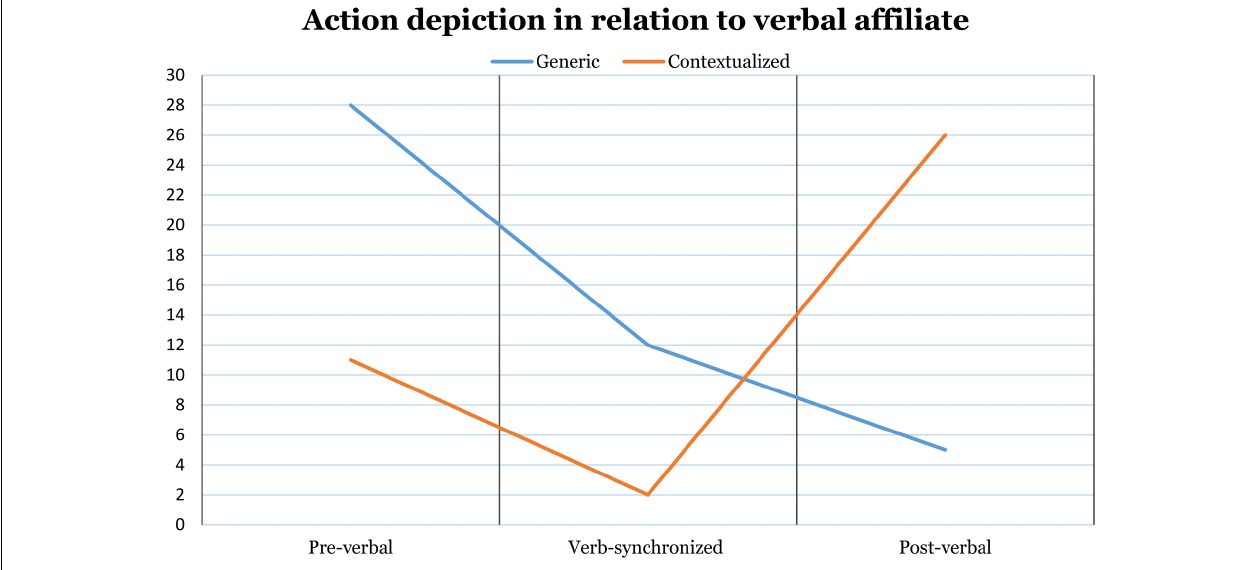
Figure 3 | Change in the absolute frequency of the two modes of action depiction depending on their temporal positions relative to verbal affiliates ( n = 84). Gestures with cross-extending strokes ( n = 8), which begin pre-verbally and end post-verbally, are